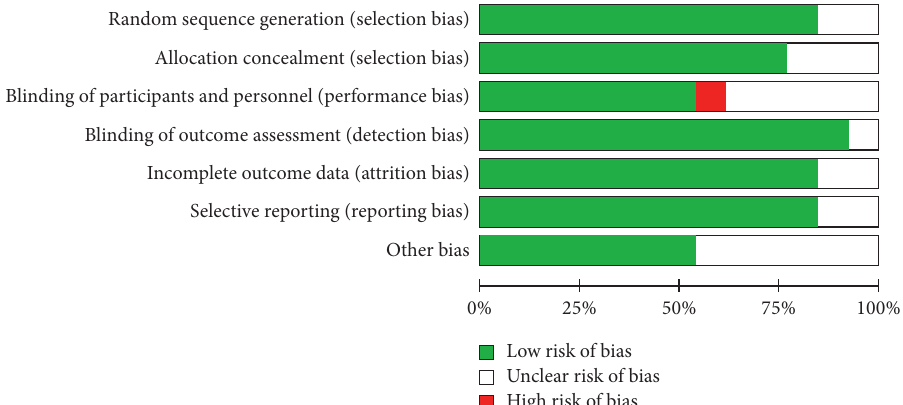
Figure 3: Risk of bias graph: review authors’ judgments about each risk of bias item presented as percentages across all included studies.